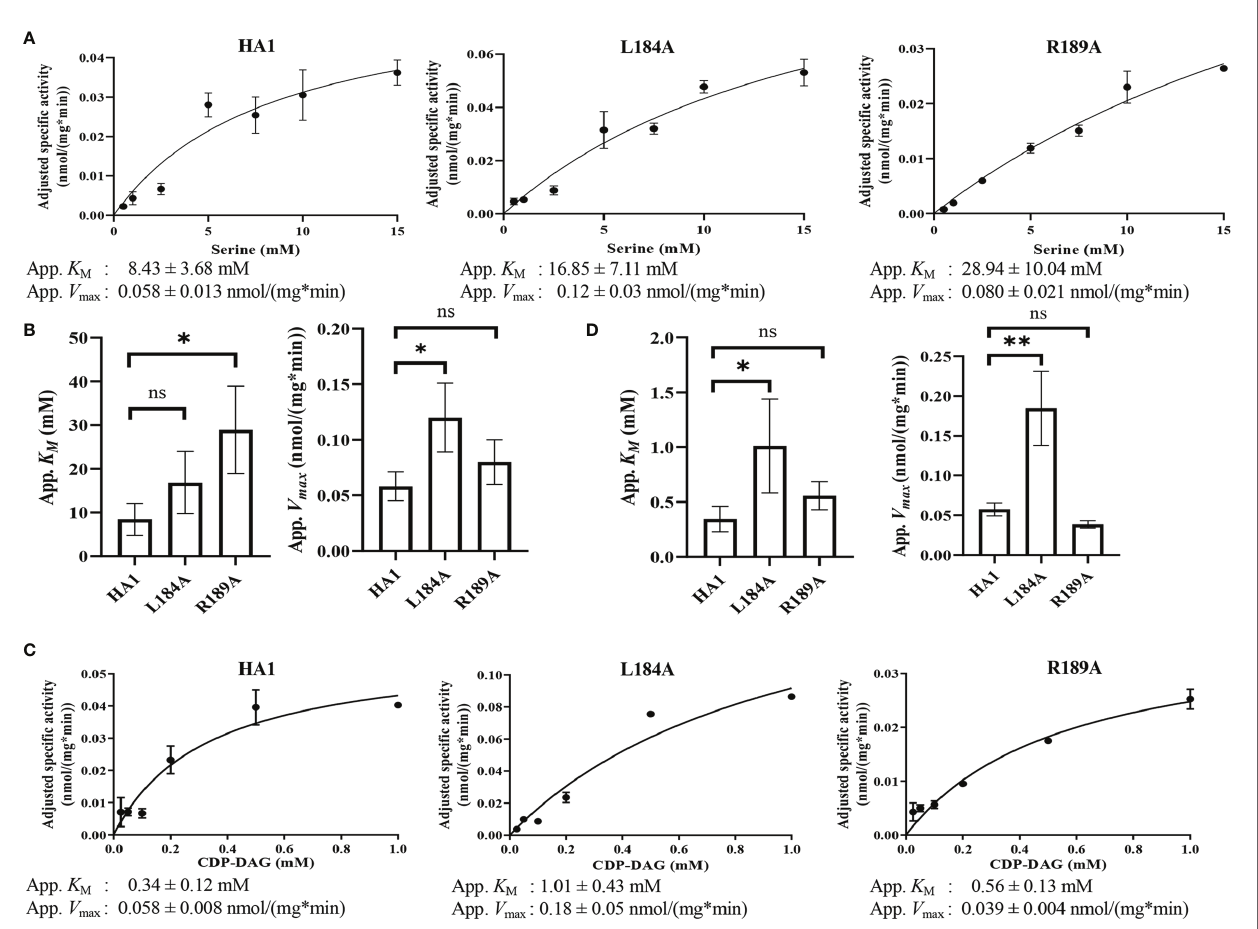
FIGURE 8 | Michaelis-Menten kinetics showed decreased serine binding capacity of R189A. The in vitro PS synthase assay was performed with varying concentrations of CDP-DAG and serine, and the Michaelis-Menten kinetics curves of HA1, L184A and R189A were shown in (A) for serine and (C) for CDP-DAG. The apparent K M and V max estimated are below the corresponding curves, and are fi t into bar graphs (B) for serine and (D) for CDP-DAG. Statistical comparisons were conducted using extra sum-of-squares F test (*p < 0.1; **p < 0.01; ns, not signi fi cant). All adjusted speci fi c activity was measured in duplicate with a total of six biological